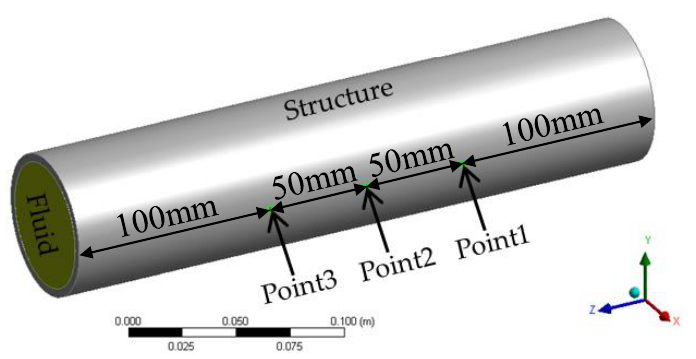
Figure 5. Diagram of cross-sections. Three data extraction points, namely, Point1, Point2, and Point3, were set in pipe wall, corresponding to the three planes in the fluid domain, as shown in Figure 6.